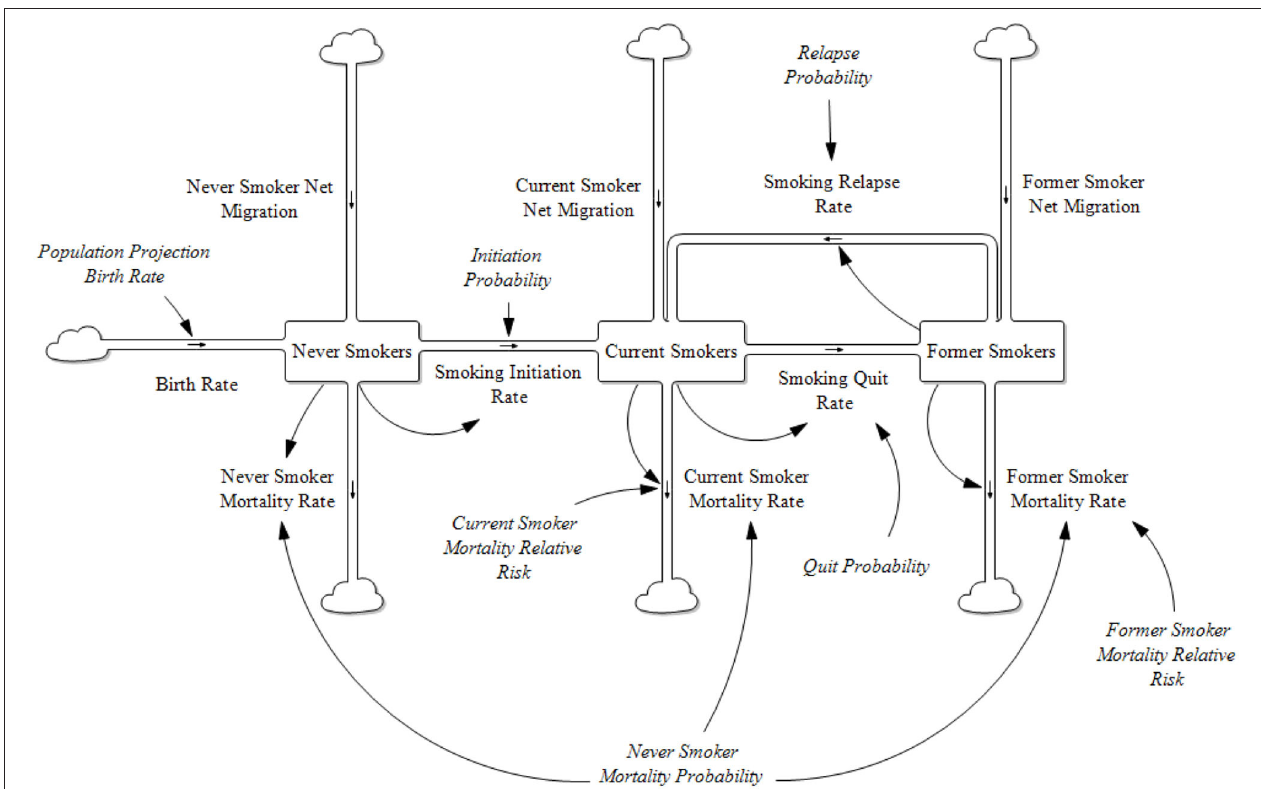
FIGURE 1 | One product model stock and flow